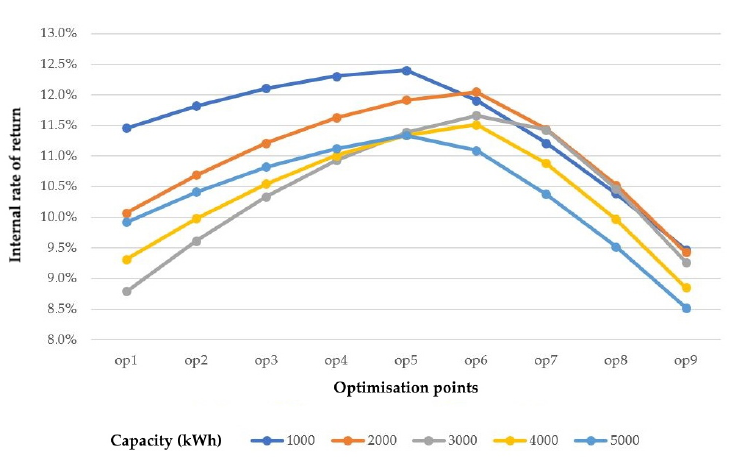
Figure 1. MOO effects for c-rate of 0.5 and battery capacities 1000–5000